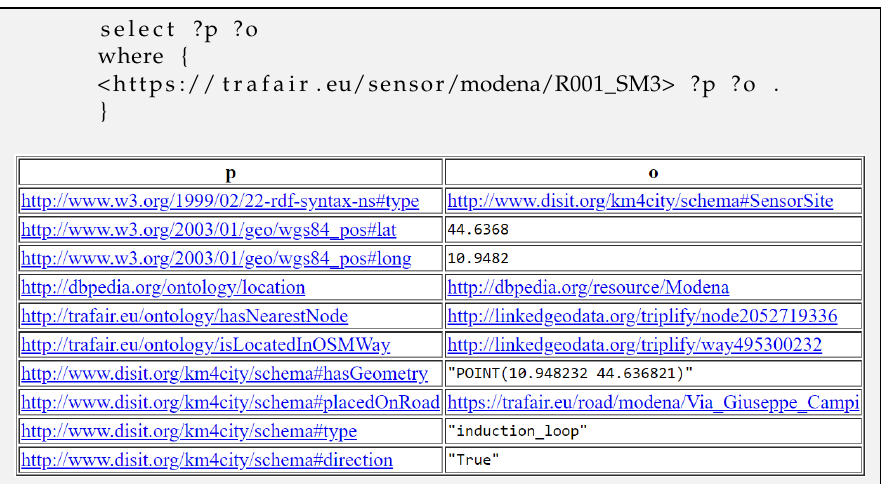
Figure 11. SPARQL query showing information related to sensor